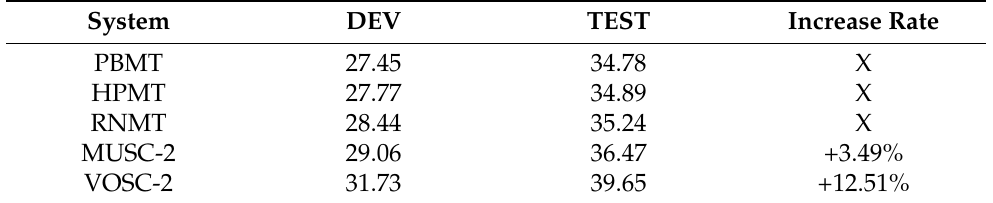
Table 6. Results on heterogeneous systems with similar performance for Uyghur–Chinese translation.